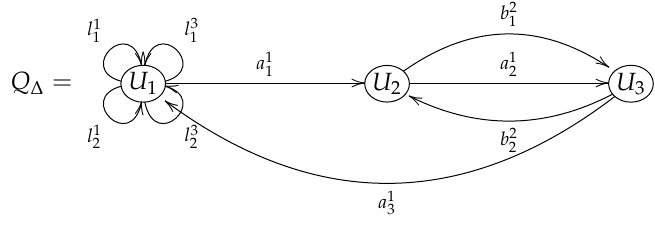
Figure 2. Brauer quiver associated Q ∆ induced by the Brauer configuration ∆